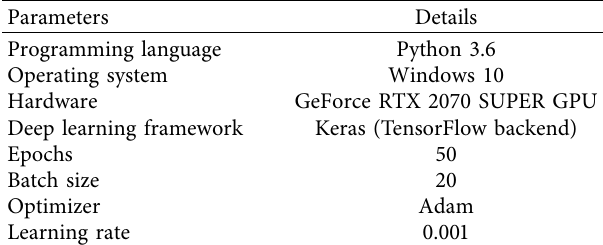
Table 2: Training details required for the proposed